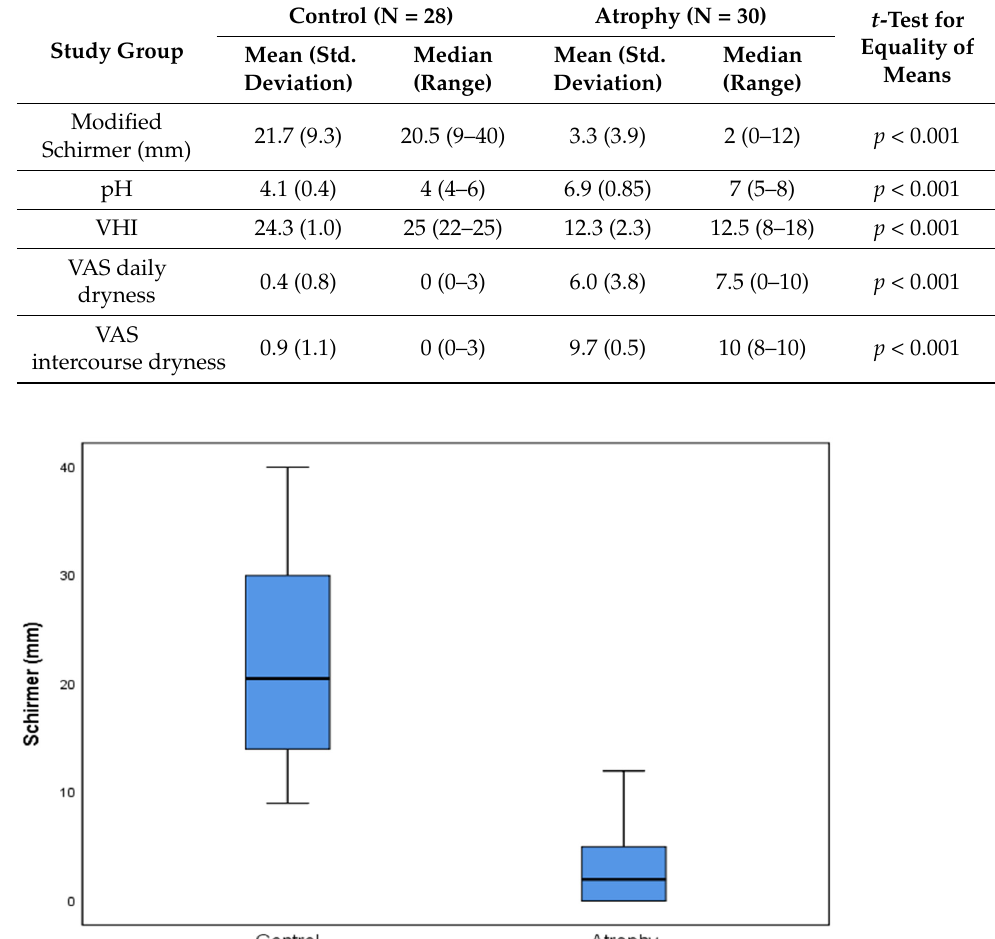
Table 3. Measurements of parameters evaluating vaginal atrophy.